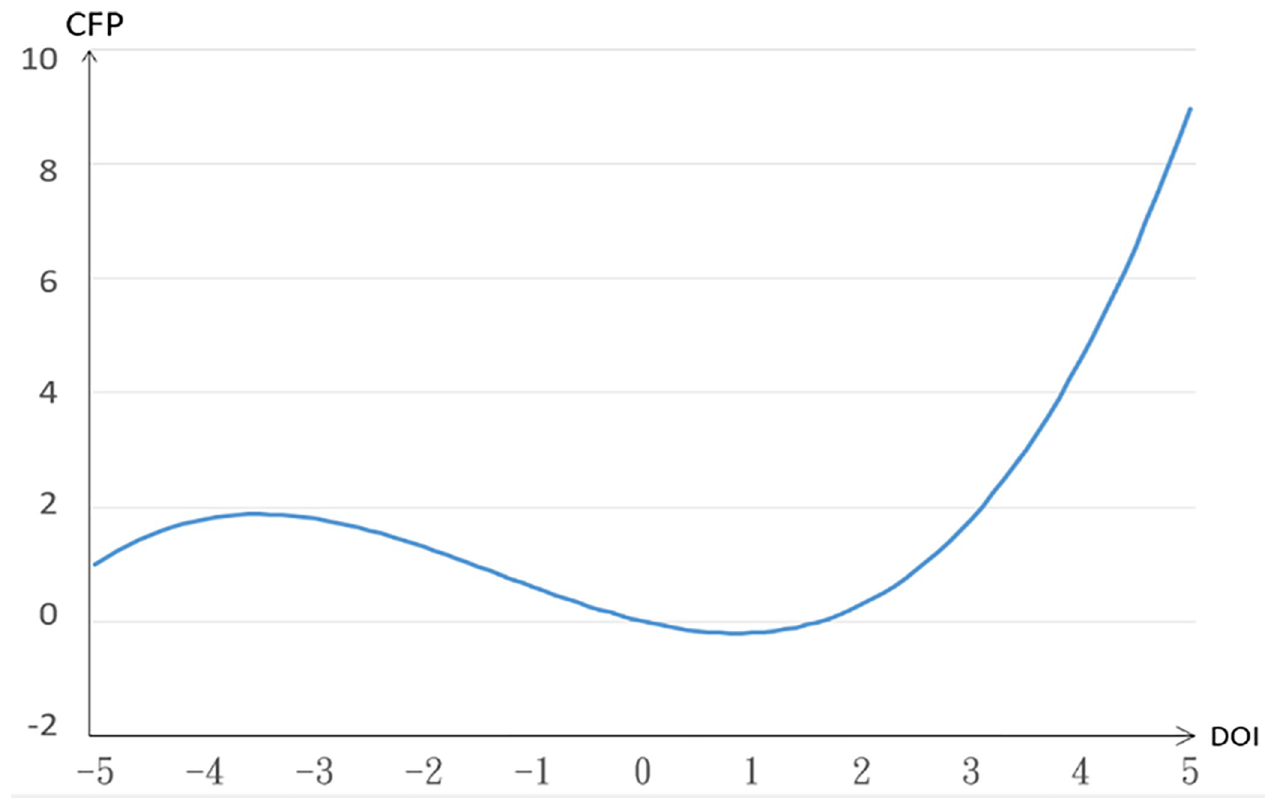
Fig 1. The relationship between internationalization and corporate